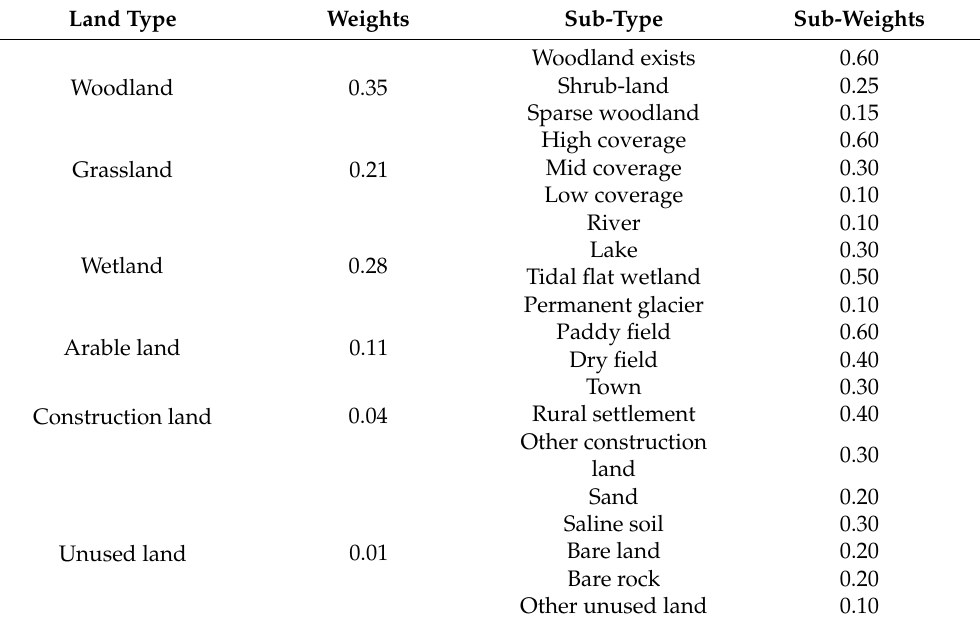
Table 3. The weight of each habitat type in the habitat-quality